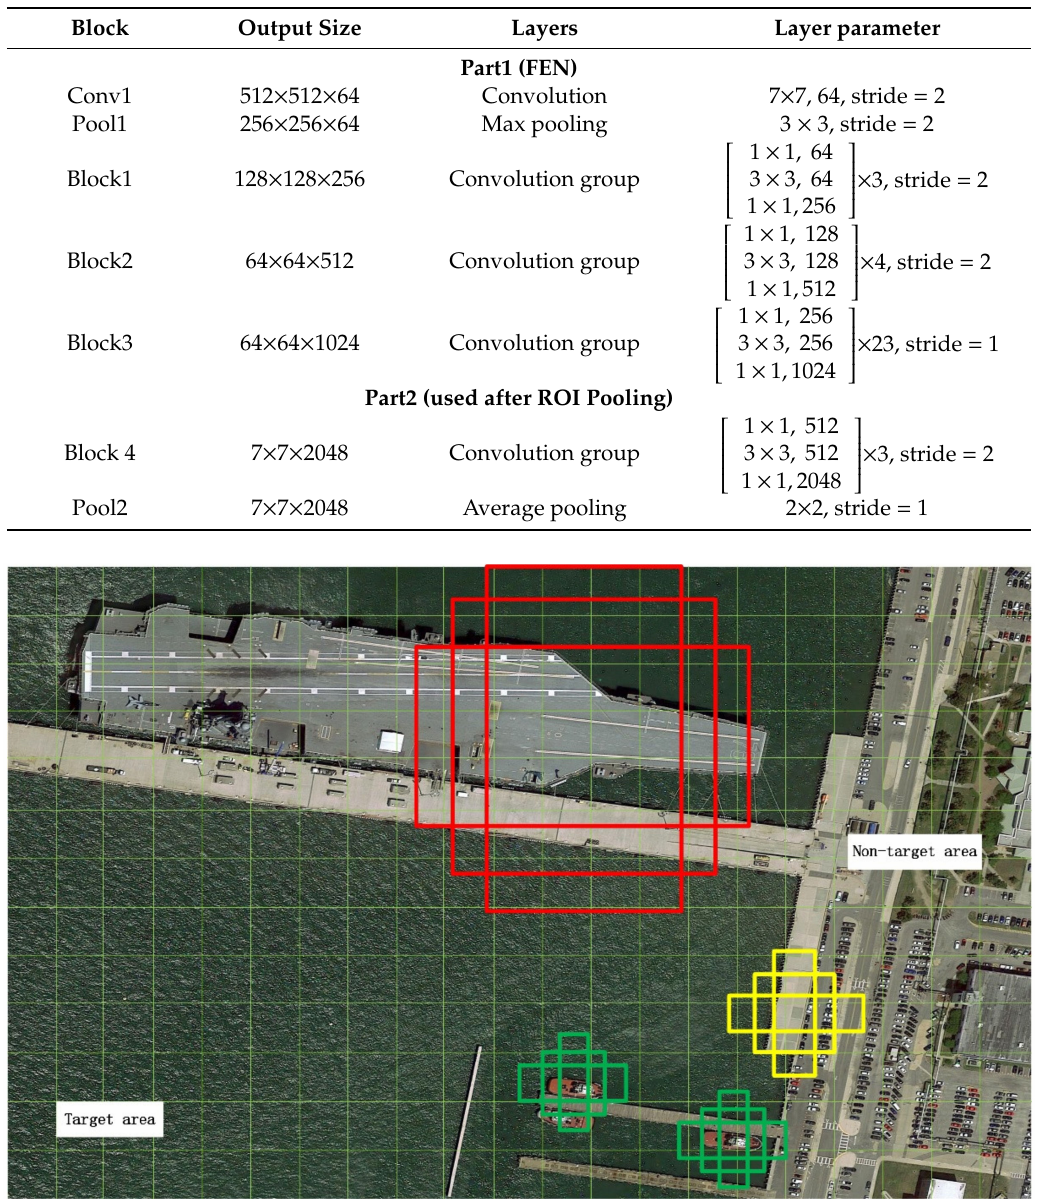
Table 1. Configuration of the Resnet-101 in object detection network.